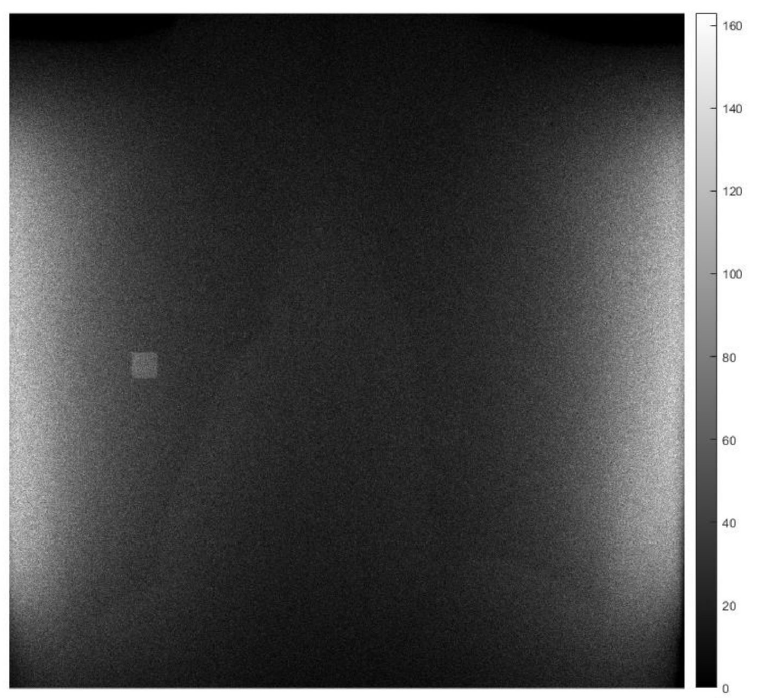
Figure 8. Fluorescence image for 5 mg/mL of